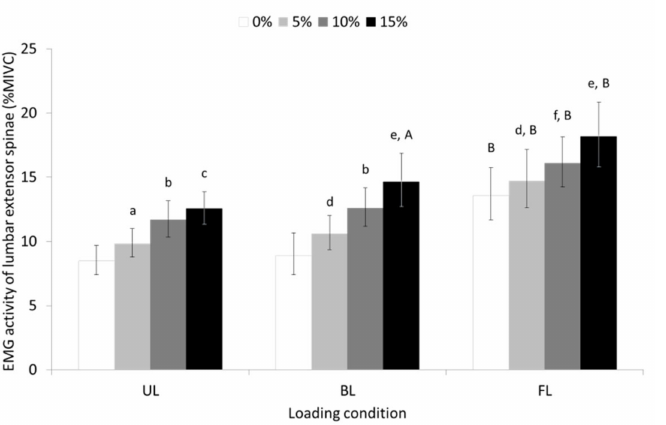
Figure 4. Geometric means and 95% confidence intervals (error bars) for the EMG activity of the lumbar erector spinae during unloaded (UL), back-loaded (BL), and front-loaded (FL) walking at 0 (level), 5, 10, and 15% uphill slope. a significant different (SD) compared to 0% slope ( p ≤ 0.001); b SD compared to 0 and 5% slope ( p ≤ 0.001); c SD compared to 0 and 5% ( p ≤ 0.001) as well as 10% slope ( p ≤ 0.05); d SD compared to 0% slope ( p ≤ 0.05); e SD compared to 0, 5 and 10% slope ( p ≤ 0.001); f SD compared to 0% ( p ≤ 0.001) and 5% slope ( p ≤ 0.05); A SD compared to UL condition ( p ≤ 0.05); B SD compared to UL ( p ≤ 0.001) and BL condition ( p ≤ 0.01 in all but 15% slope where p ≤ 0.05).